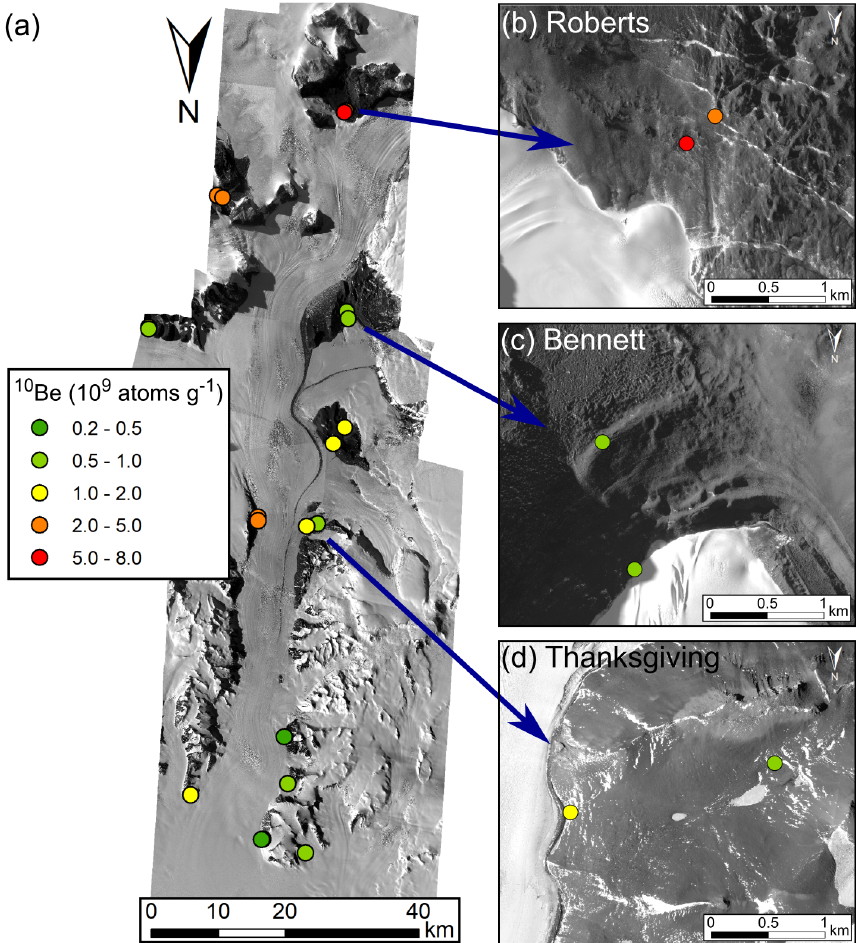
Figure 5. Spatial distribution of surface meteoric 10 Be concentrations in the Shackleton Glacier region (a) . Where possible, two samples were collected at each location to represent surfaces closest to the glacier, which might have been glaciated during recent glacial periods, and samples furthest from the glacier that are likely to have been exposed during recent glacial periods. Insets of Roberts Massif (b) , Bennett Platform (c) , and Thanksgiving Valley (d) are included, as these locations have both 10 Be and NO − provided by the Polar Geospatial